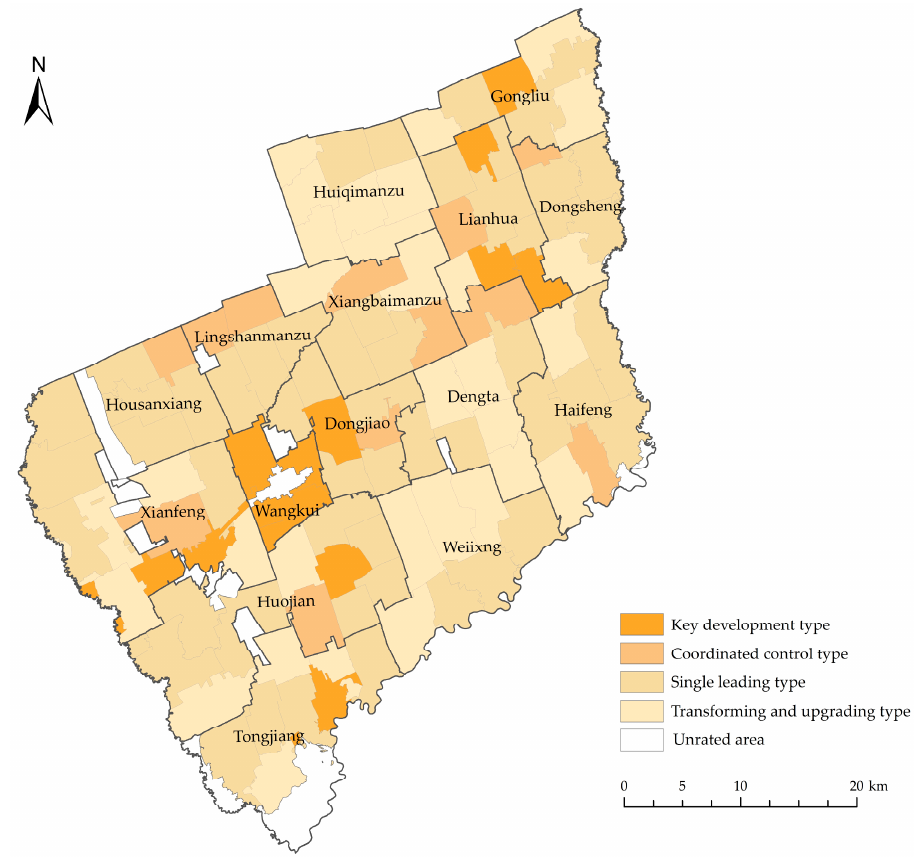
Figure 4. Distribution map of optimized types of rural residential